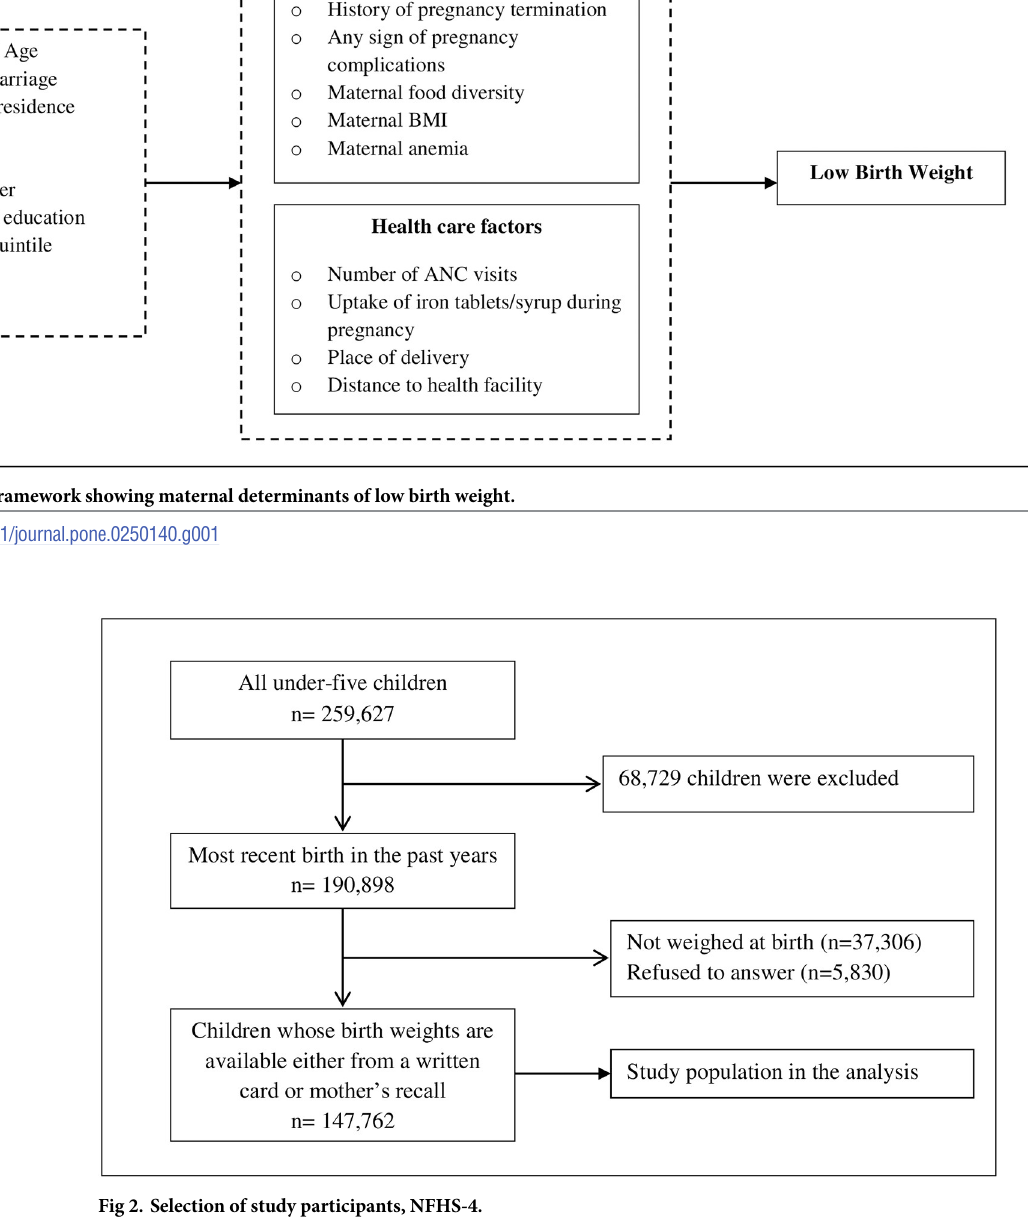
Fig 2. Selection of study participants,